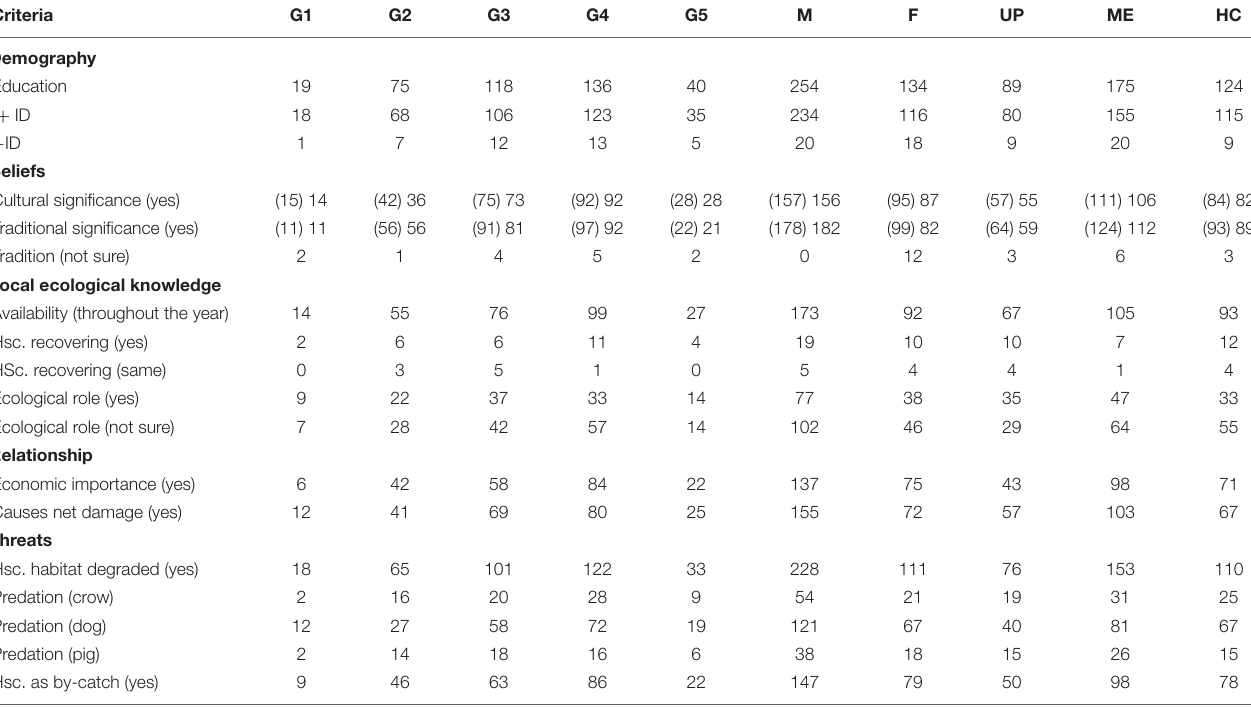
Table headings are abbreviated as G = group, M = male, F = female, UP = upper primary, ME = middle elementary, and HC = high school/college. Abbreviated components listed in criteria include + ID = number of respondents who successfully identified horseshoe crabs, − ID = number of respondents who were not able to identify horseshoe crabs, and Hsc. = horseshoe crab(s). Values in (brackets) for “beliefs” section refer to total number of respondents. Values in other sections refer to number of respondents who successfully identified horseshoe crab from pictures presented to them.